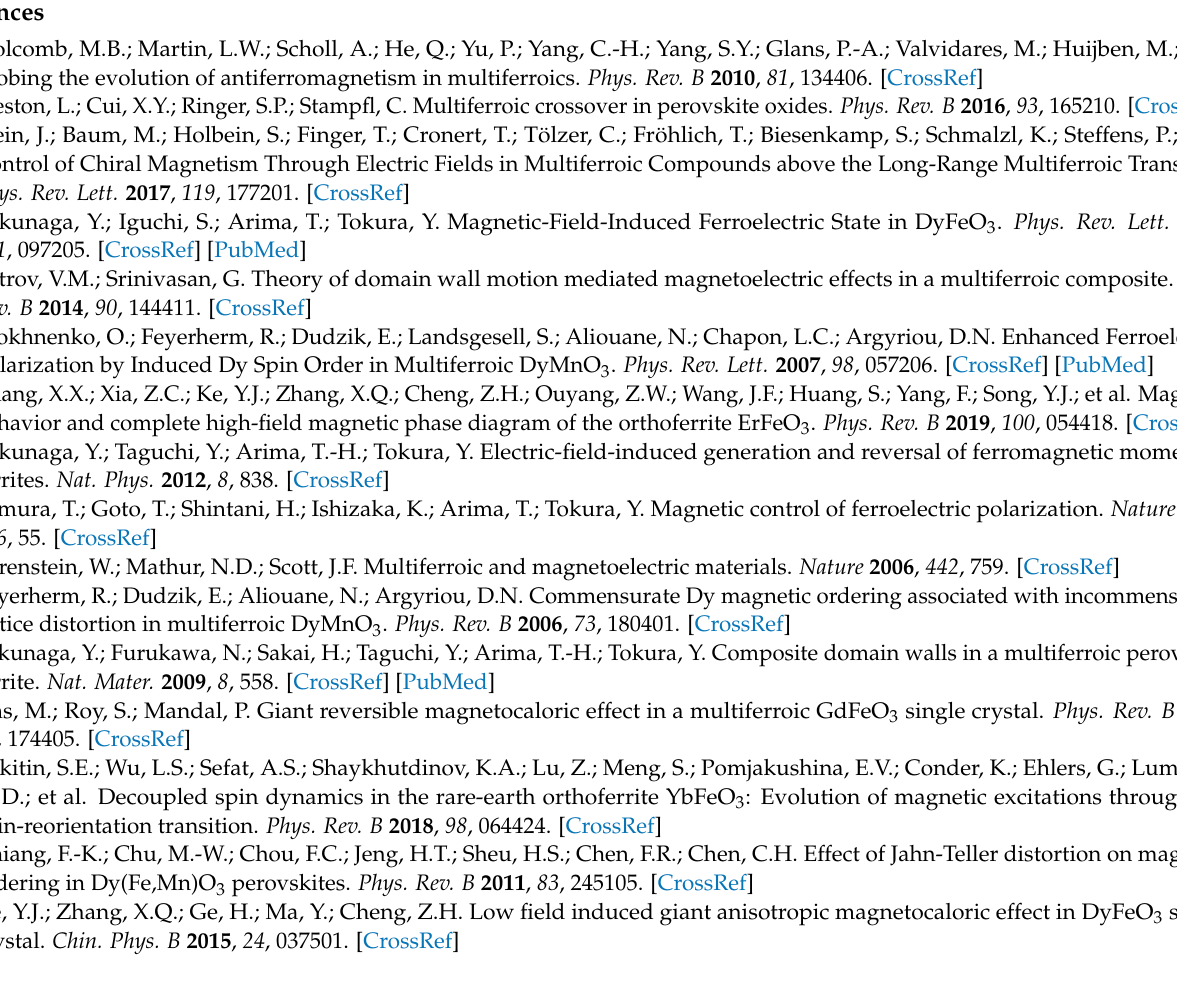
single crystal; Figure S1: The measurement schematic of the electric polarization ( Pc ) under pulsed magnetic fields; Figure S2: Magnetic phase diagrams determined with the magnetization and polar- ization